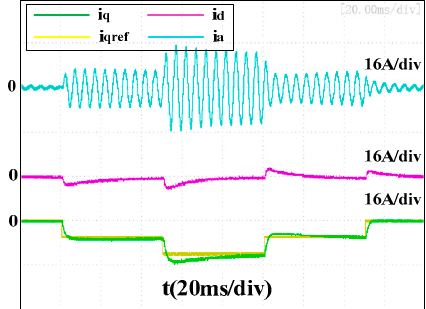
Figure 17. d-q axis current waveform of the current controller without decoupling at 12,000 rpm with Kp = 500 π Ls.